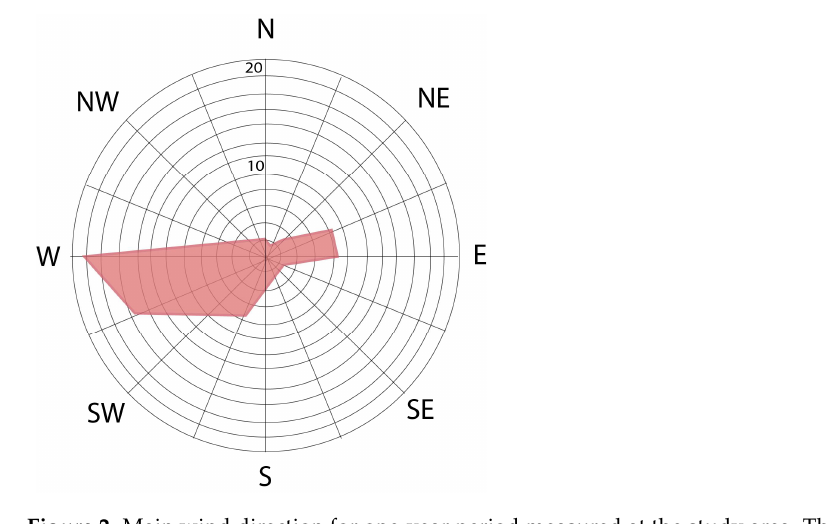
Figure 2. Main wind direction for one-year period measured at the study area. The wind rose graph shows dominant Western winds and periodical Eastern